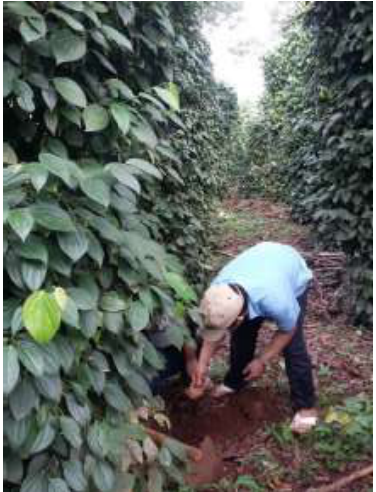
Figure 1. Sampling roots of black pepper . Young root samples collected from healthy black pepper, 4–5 years old, 1 m from the trunk in 0–30 cm depths.